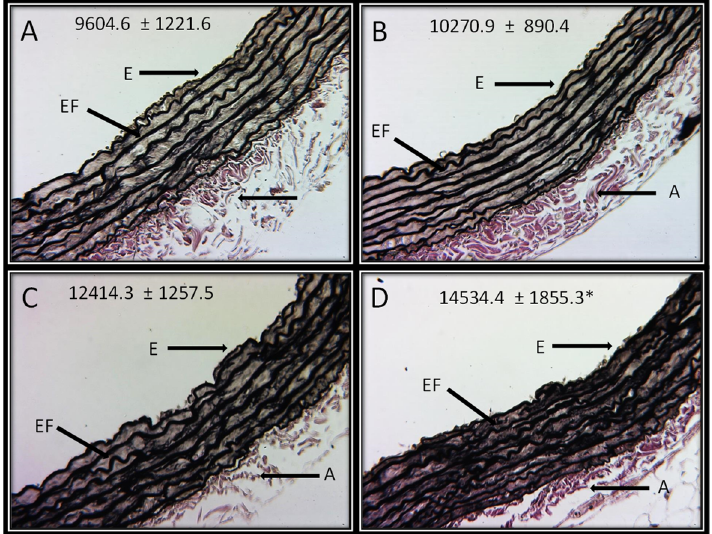
Figure 4. Representative photomicrographs of the histological segments of the aortas of the experimental rats receiving the different percentages of the HSL infusion. The values are expressed as the mean ± SE and units in arbitrary pixels. * C vs. HSL at 6% p = 0.04. The histological sections were made and stained by Jones methylamine silver stain technique at 16x. Abbreviations: ( A ) = Control, ( B ) = HSL at 1.5 %, ( C ) = HSL at 3 %, ( D ) = HSL at 6%, E = Endothelium, A = Adventitia, EF = Elastic fibers.